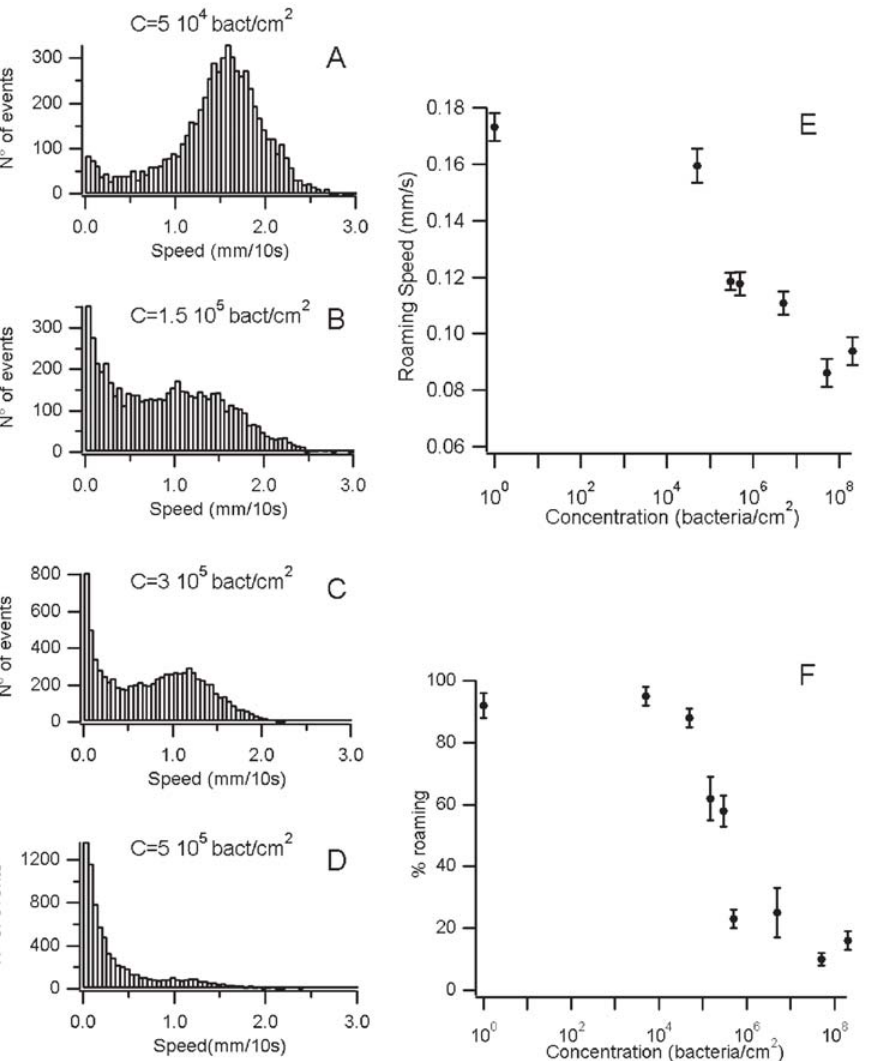
Figure 2. C.elegans adapts its roaming behavior to food concentration, both by changing the dwelling/roaming percentage and the speed during the roaming phase. (A–D) Speed histograms of WT C. elegans on different concentration of bacteria (A: 5 10 4 B: 1.5 10 5 C: 3 10 5 D: 5 10 5 bacteria per cm 2 , at least 15 worms have been recorded per condition, results are presented as mean 6 s.e.m.) (E) Speed in the roaming phase decreases with food concentration (F) The percentage of time spent in the roaming phase is a function of food concentration (logarithm scale). Worms switch from an all-roaming to mostly dwelling in one decade of food concentration.